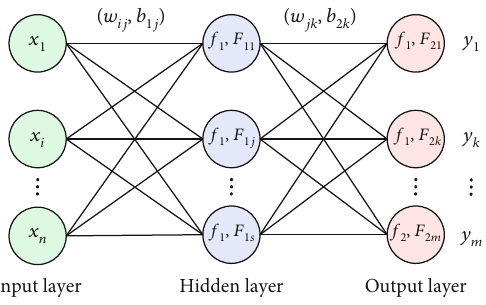
Figure 1: The architecture of BP neural